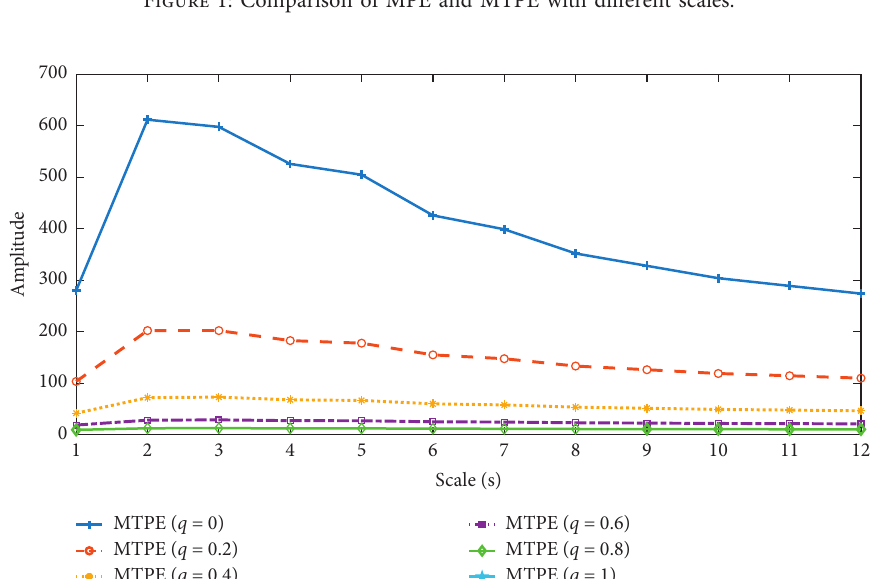
Figure 2: Effects of positive entropy index q on